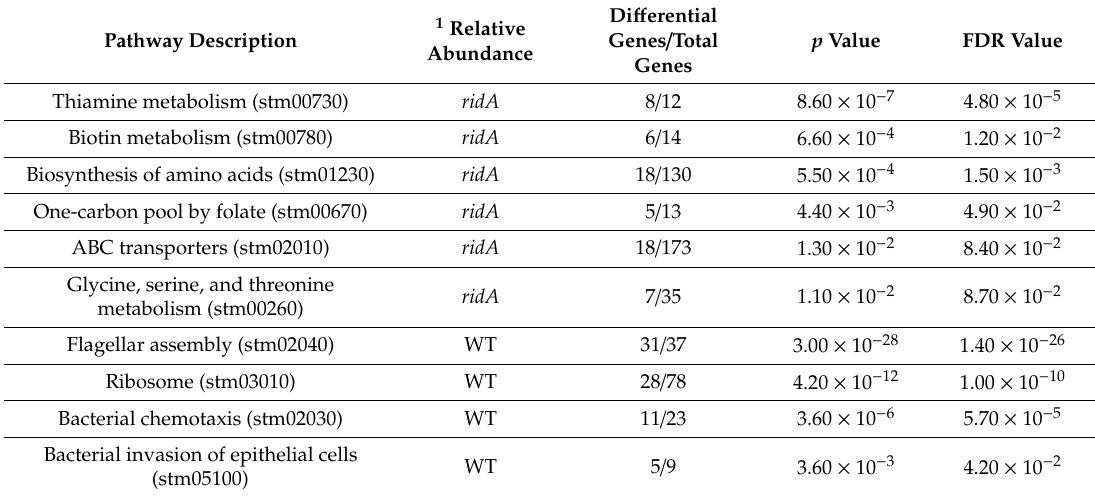
Table 3. KEGG pathways di ff erentially regulated between wild-type and ridA S. enterica. Pathway